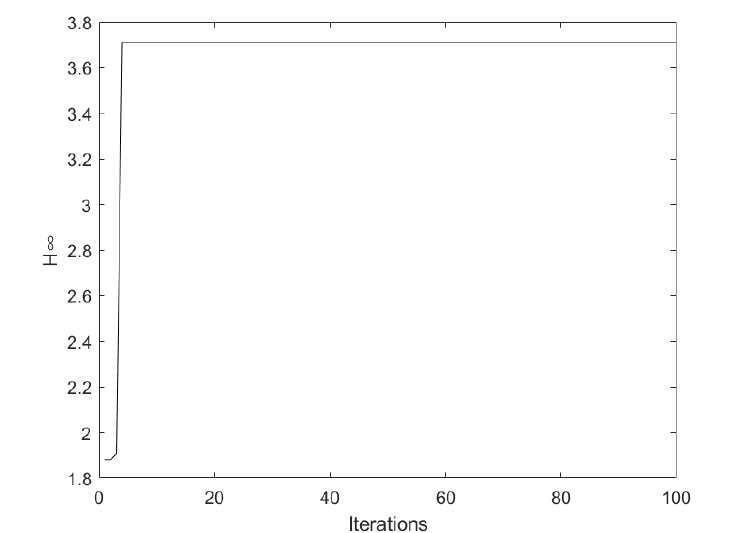
Figure 3. Iterative curve of improved discrete state transition